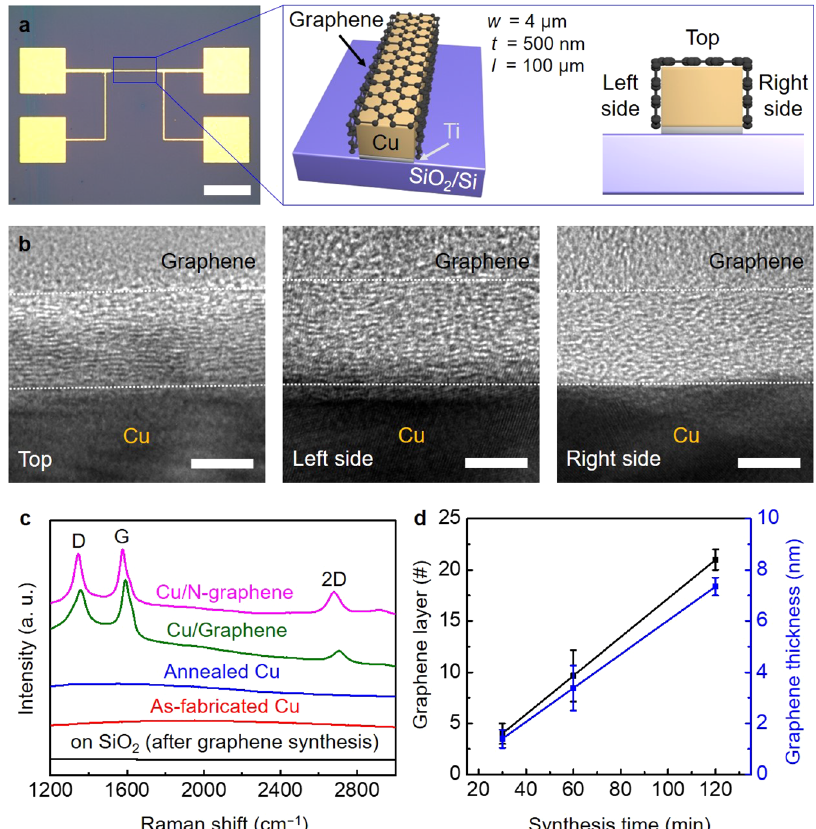
Fig. 1 Characteristics of graphene-capped Cu interconnects. a Optical and schematic images of graphene-capped Cu interconnects fabricated by direct synthesis of graphene on Cu interconnects via APCVD using benzene and pyridine at 400 °C. b HRTEM images of graphene synthesized on the top, left, and right sides of the Cu interconnect for 120 min. c Raman spectra of as-deposited Cu, annealed Cu, undoped and N-doped graphene-capped Cu interconnects measured on Cu surfaces and SiO 2 of substrate after graphene synthesis. d The number and thickness of graphene synthesized on the Cu interconnect using benzene estimated TEM images of Supplementary Fig. 5. Scale bars, 100 µm in a , 5 nm in b